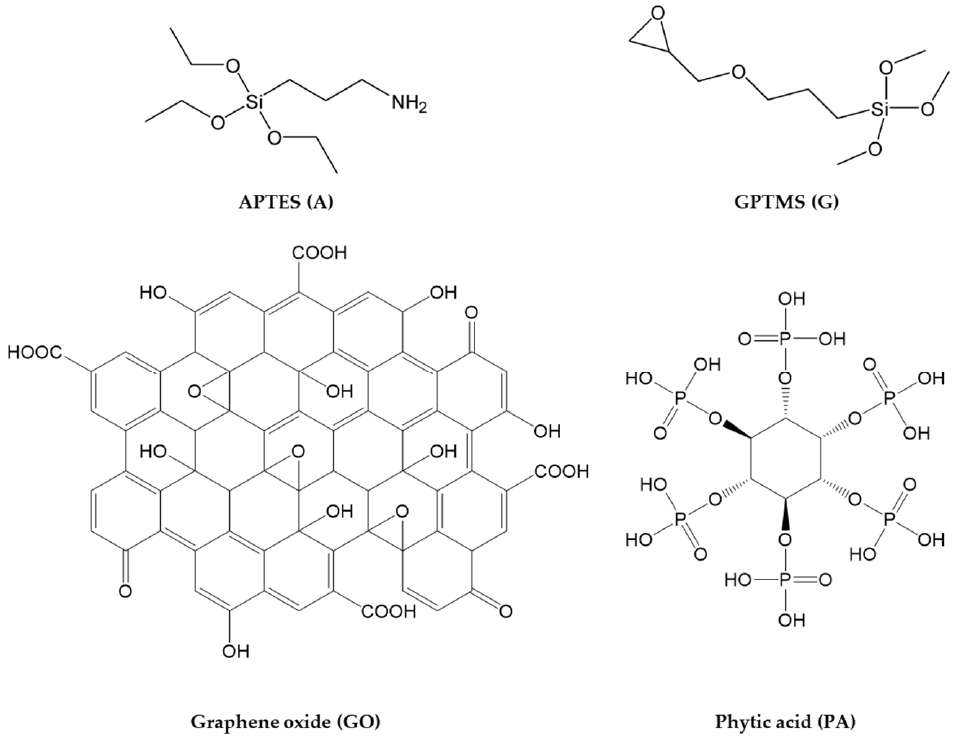
Figure 1. Functional molecules employed for the preparation of the waterborne anticorrosive coat- ings.